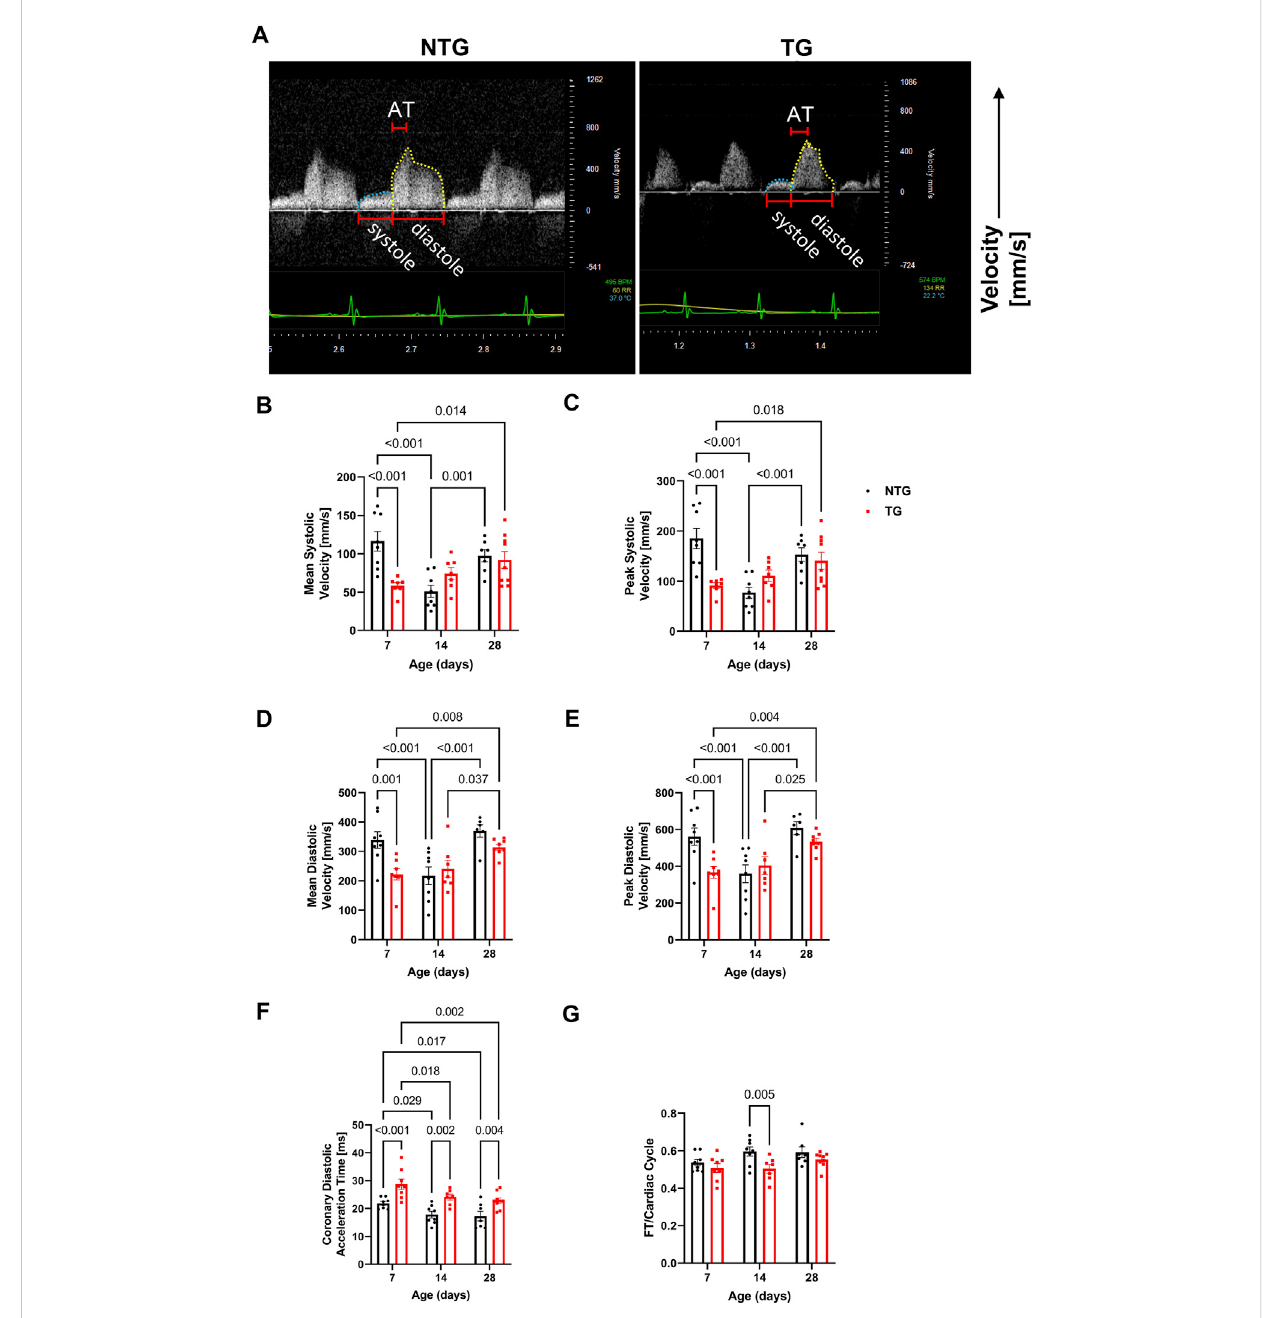
FIGURE 4 Time-dependent changes in coronary fl ow. (A) Representative Doppler echo images of P14 coronary fl ow charts, with systolic fl ow highlighted in blueanddiastolicinyellow.Summarydatarepresent: (B) meansystoliccoronary fl owvelocity, (C) peaksystoliccoronary fl owvelocity, (D) meandiastolic coronary fl ow velocity, (E) peak diastolic coronary velocity, (F) coronary diastolic acceleration time, and (G) total diastolic fl ow time (FT) normalized to cardiac cycle length. Data are presented as mean ± SEM, NTG n = 6, TG n = 6 and analyzed by 2-way ANOVA followed by Fisher ’ s LSD test; NTG, non-transgenic; TG